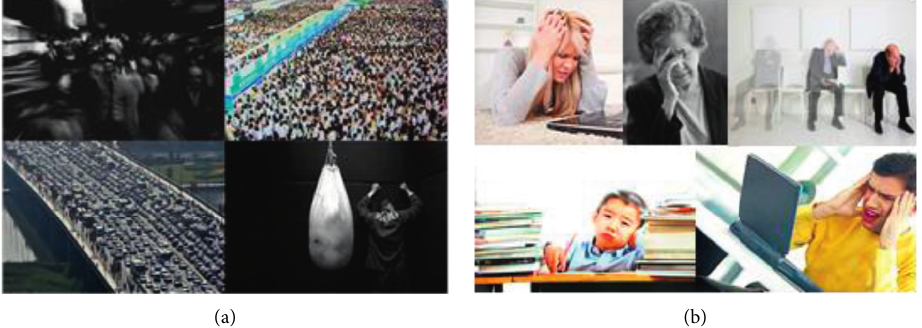
Figure 1: Parts of the anxiety induction material. (a) Anxiety induction visual materials. (b) Pictures of different people in anxiety.